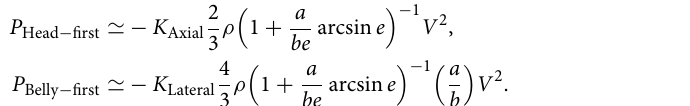
Figure 5 shows the maximum impact force and impact pressure versus animal mass. Green symbols represent the lateral impact (i.e., belly-first dive), whereas blue symbols represent the axial impact (i.e., head-first dive). In most cases, we do not have quantitative measurements of diving speed or postures. Thus, we estimate the diving speed from the jumping height as V 2 = 2 gH as in 11 . In Fig. 5a, the belly-first dive produces more impact force than the head-first dive, which is quite intuitive due to the difference in the cross-sectional area depend- ing on the diving direction. However, the impact pressure does not increase much with the animal mass as in Fig. 5b. This constant pressure would indicate that all animals feel a similar level of pressure and safely dive into water regardless of their body weight or length.